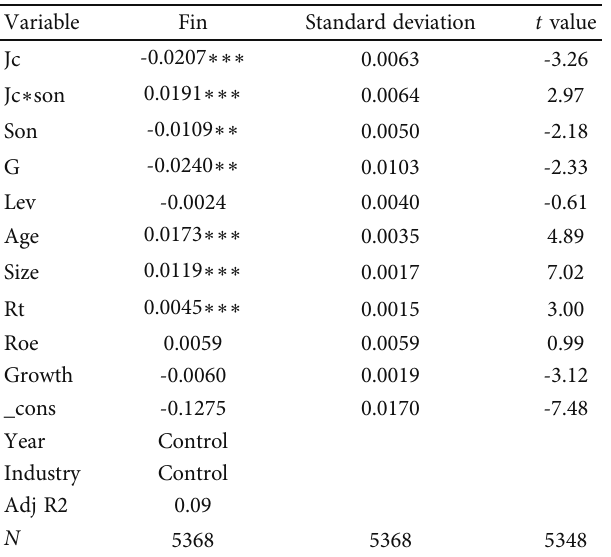
Table 4: Regression results of intergenerational inheritance, second-generation identity, and fi nancialization of family